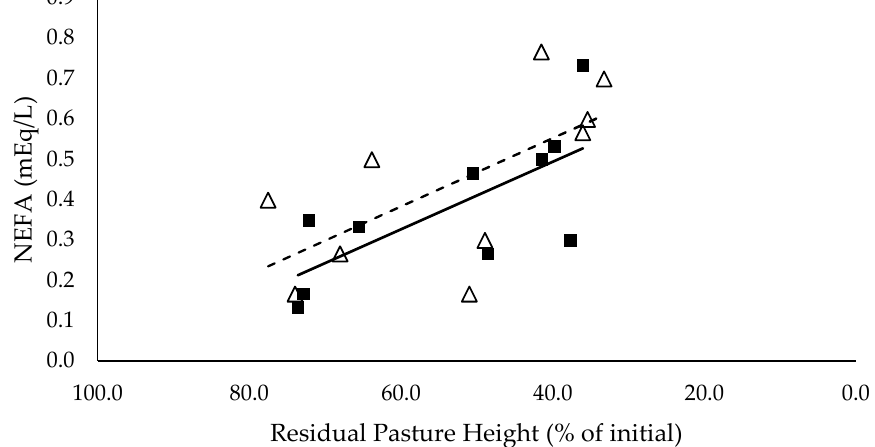
Figure 5. The relationship between the serum non-esterified fatty acid (NEFA) (mEq / L) and residual pasture height (% of initial) for high ( ■ ) and low (Δ) mixed ration levels. Lines were fitted for high (solid) and low (dashed) mixed ration levels.